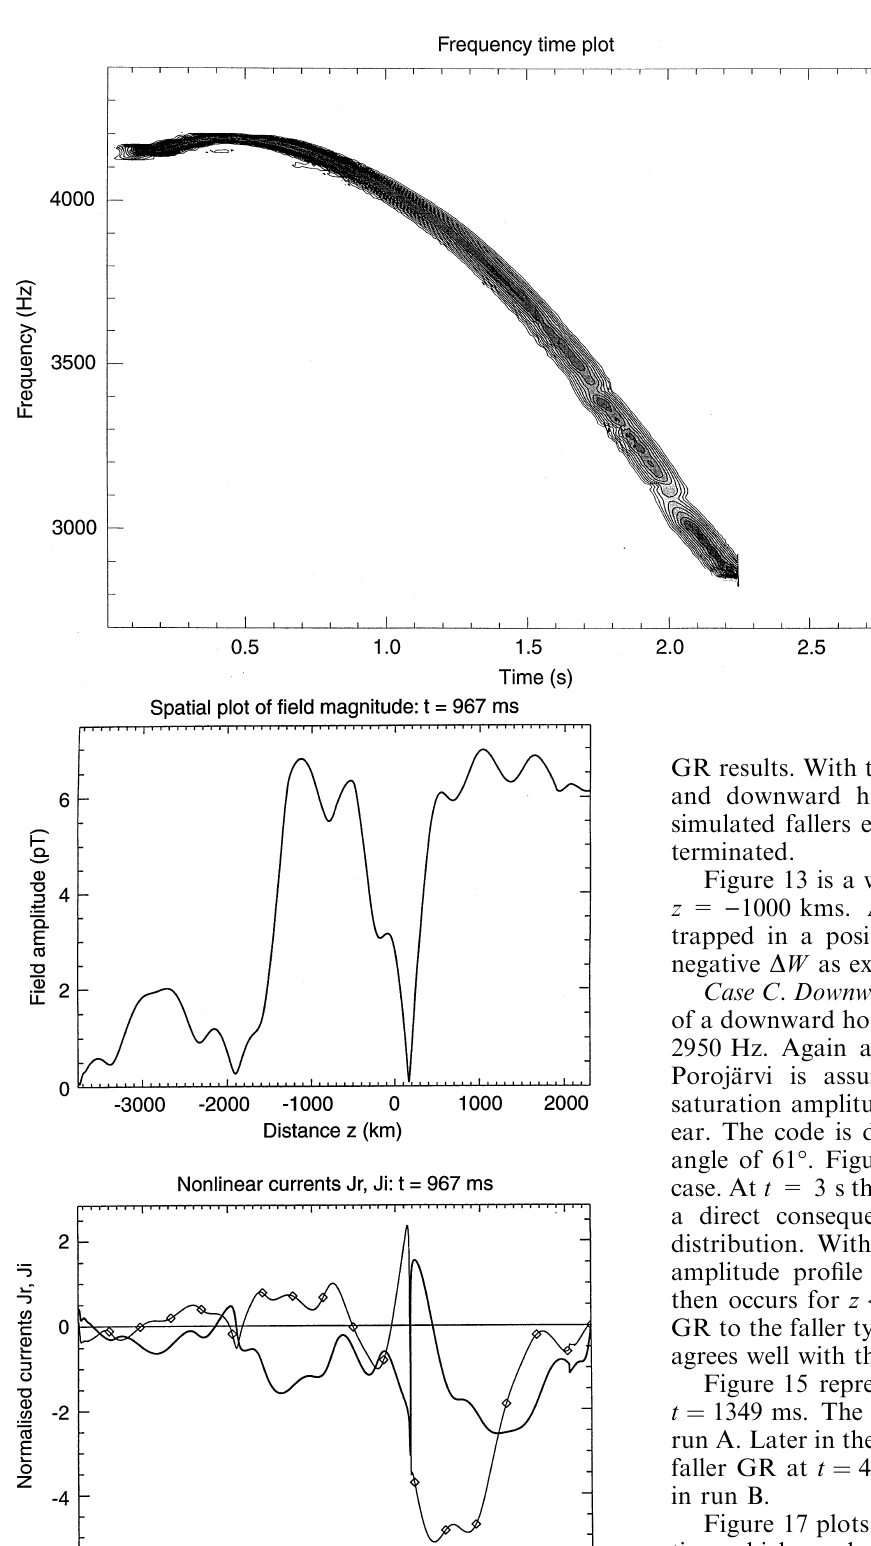
Fig. 11. Case B. Snapshot of the faller generation region at t = 967 ms. The amplitude profile extends well upstream of the equator. Particle trapping in this positive inhomogeneity region results in J i > 0, which gives rise to the